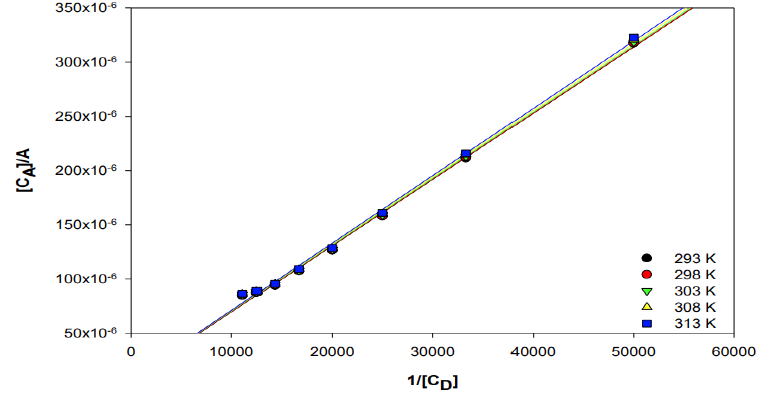
Figure 10. Benesi – Hildebrand plot of AMFP – TCNE CT complex in DCE at different temperatures. Table 1. Benesi – Hildebrand spectral data of AMFP – DDQ CT complex in different solvent systems. Abs. at max = 584 nm ANCHCl 3